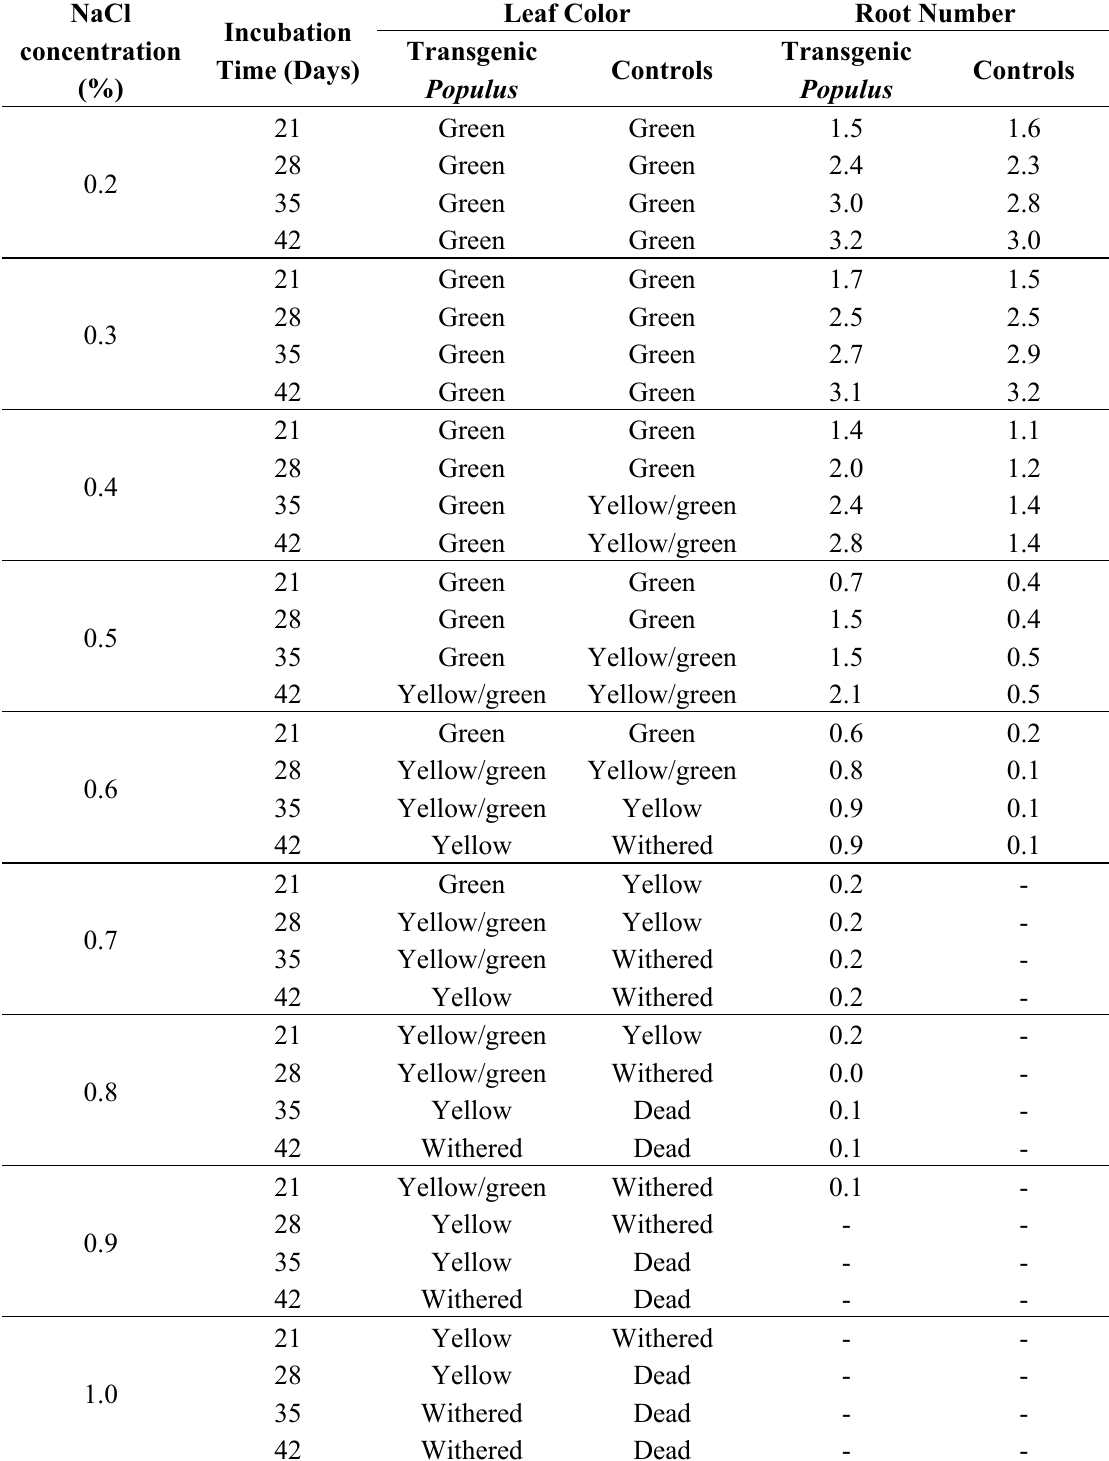
Table 2. Rooting ability at various NaCl